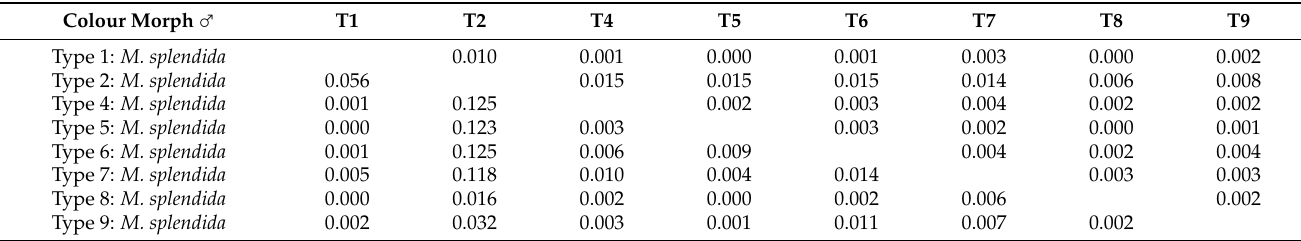
Table 2. Pairwise-corrected (K2P) genetic distance among the colour morphs of the M. splendida species. Colour Morph